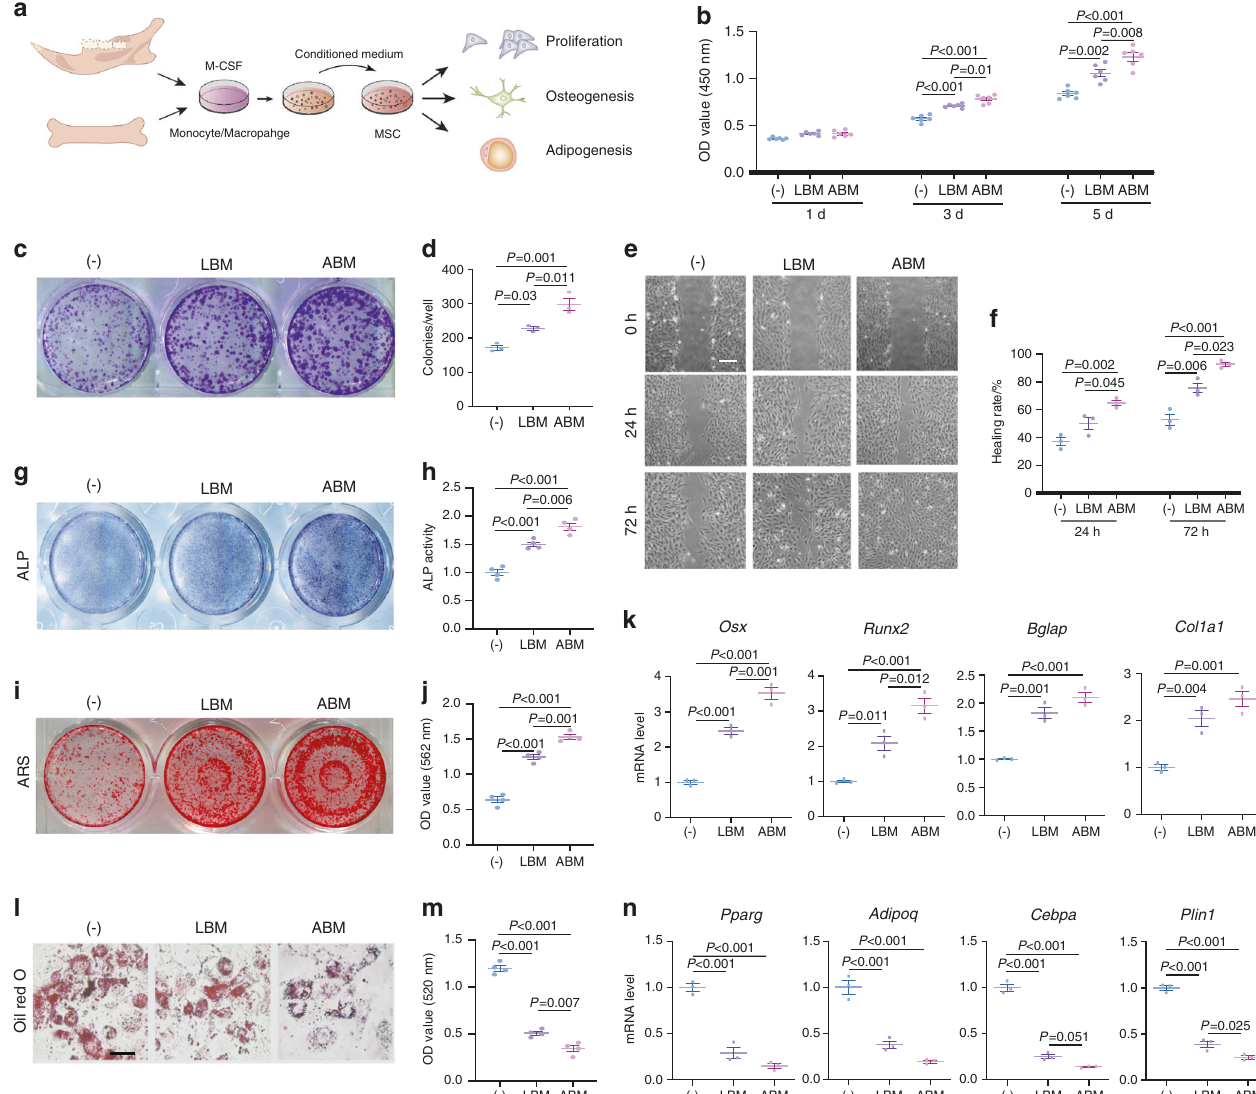
Fig. 5 Regulatory effect of monocytes/macrophages on MSCs. a Flow chat of the experimental procedures. Conditioned mediums of ABM- and LBM-derived monocytes/macrophages were supplemented into the MSCs culture, respectively. b Proliferation assay of MSCs at 1d, 3d, and 5d by CCK8. c , d Colony formation of MSCs at 14 days via crystal violet staining and quantitative analyses. e , f Effects of macrophage- conditioned medium on the migration of MSCs. Scale bar, 200 μ m. g , h ALP staining and ALP activity measurement of MSCs after induction for 7 days. i , j ARS staining and quantitative analyses after 21 days induction. k RT-qPCR results for the osteogenesis-related genes after 7 days induction. l , m Oil red O staining and quantitative analyses of MSCs. Scale bar, 50 μ m. n RT-qPCR results for the adipogenesis-related genes after 21 days